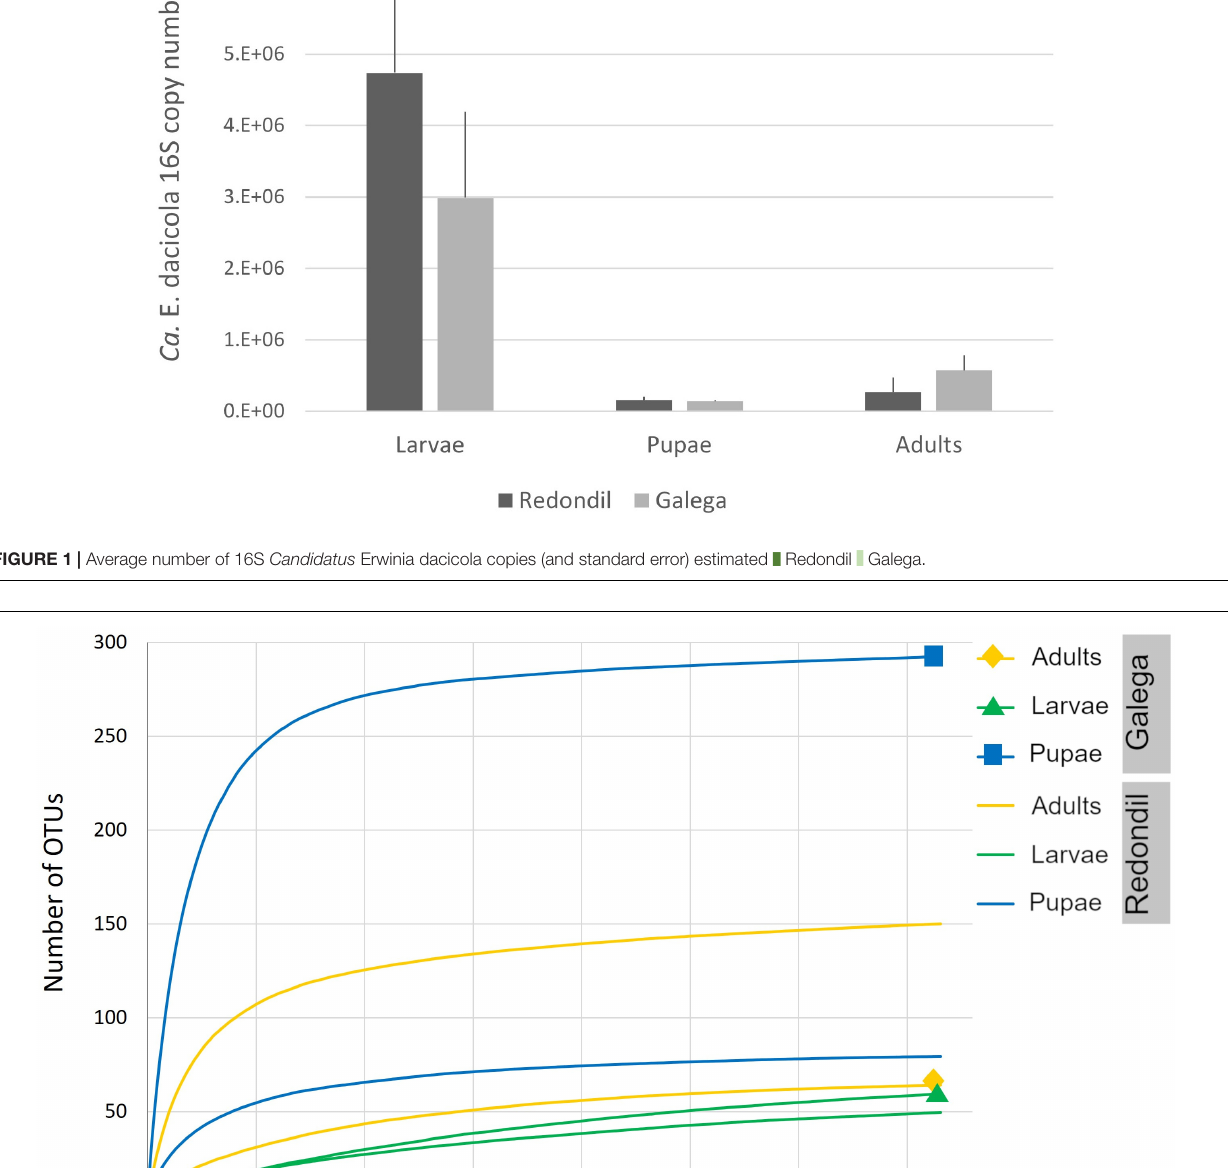
96 in the pupae, and 49 in the adults). No representative of the phylum “Bacteroidetes” (1,107 records) was present in all samples. Approximately 10% of these records (111) were